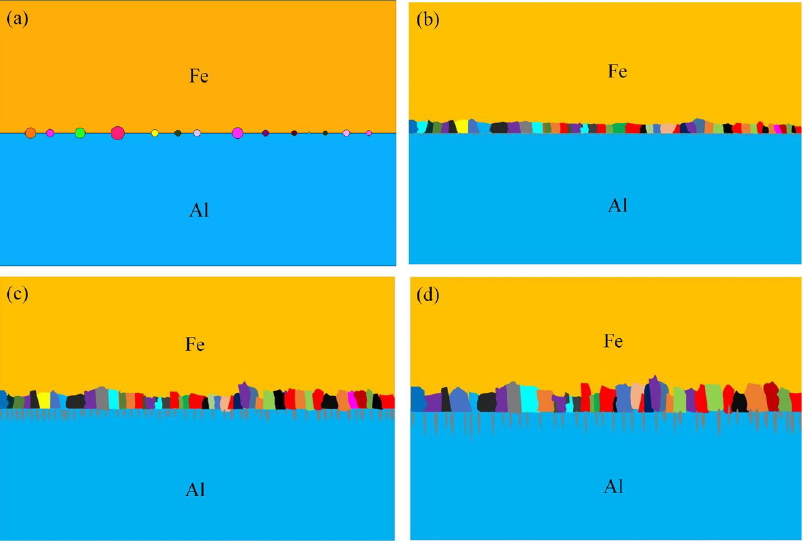
Figure 10. Layered microstructure morphology of interface IMC, ( a ) Nucleation stage, ( b ) Fe 2 Al 5 layered growth, ( c ) Fe 4 Al 13 nucleates and grows, ( d ) Stable growth stage.